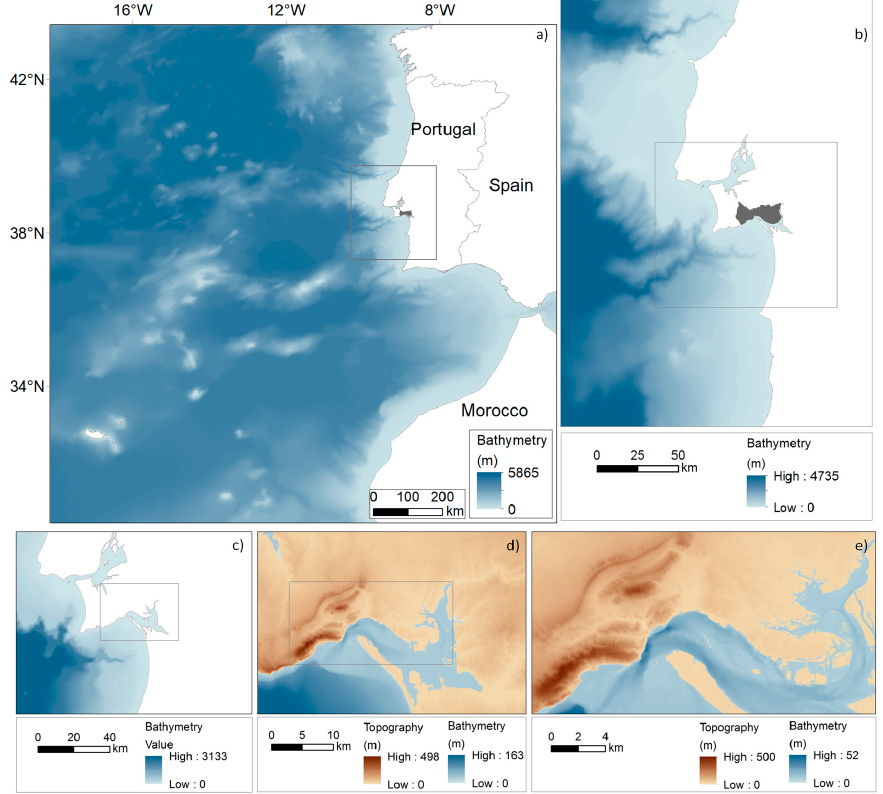
Figure 4. Conditions of the tsunami numerical model setting to Setubal municipality with cell sizes of: ( a ) 810 m; ( b ) 270 m; ( c ) 90 m; ( d ) 30 m; ( e ) 10 m.